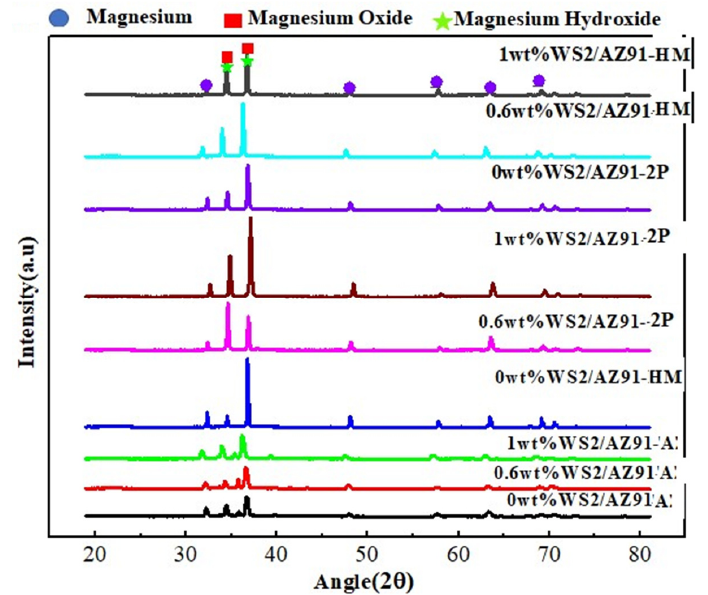
Figure 9. XRD analysis of corroded WS 2 /AZ91 composites.